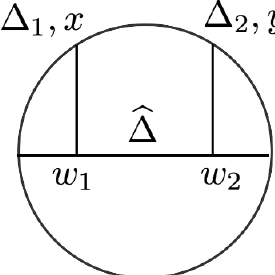
Figure 4. A bulk channel exchange Witten diagram W bulk in the probe brane setup.